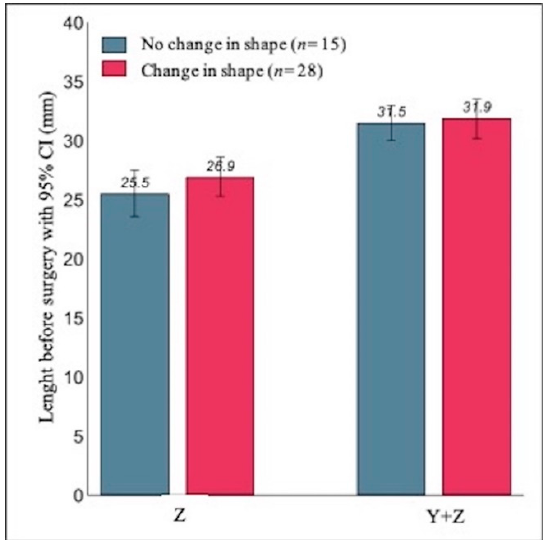
Figure 7. Mean Z and (Y + Z) values measured before surgery and their relationship with the change of the fundal uterine shape at three months after surgery in patients scheduled for second surgery ( n = 43).